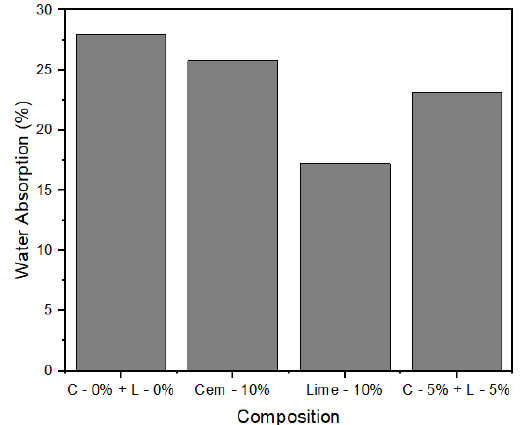
Figure 10. Water absorption results for the adobe blocks with manure.